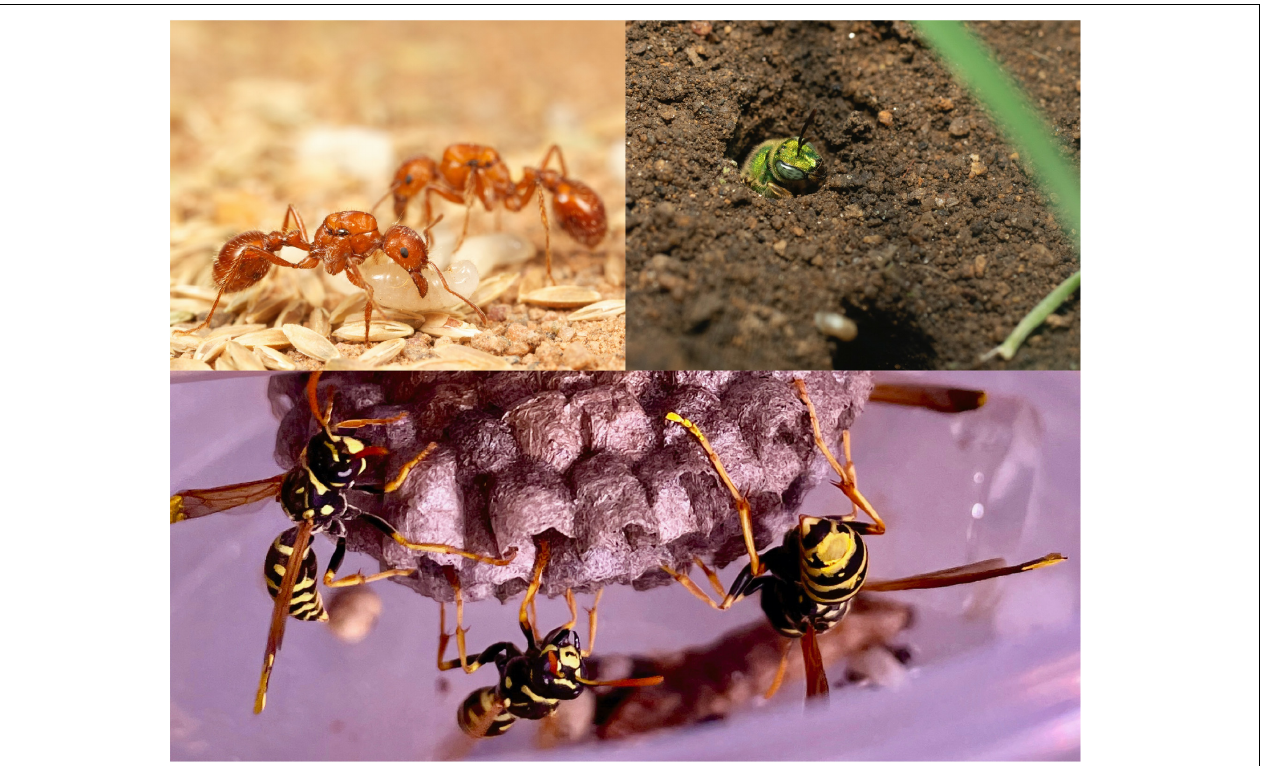
FIGURE 1 | Examples of non-kin sociality are widespread across hymenopteran taxa. In the ants, unrelated foundresses may cooperate to rear eusocial colonies, as in the harvester ant Pogonomyrmex californicus (top left; photo by Elizabeth Cash). Similarly, foundresses of some wasp species, like the paper wasp Polistes dominula (bottom; photo by Meagan Simons), may cooperatively found eusocial nests with non-relatives. Non-kin associations are also found among the communal bees, such as the sweat bee Agapostemon virescens (top right; photo by Nicholas Dorian), which shares nest-entrance guarding duties with unrelated